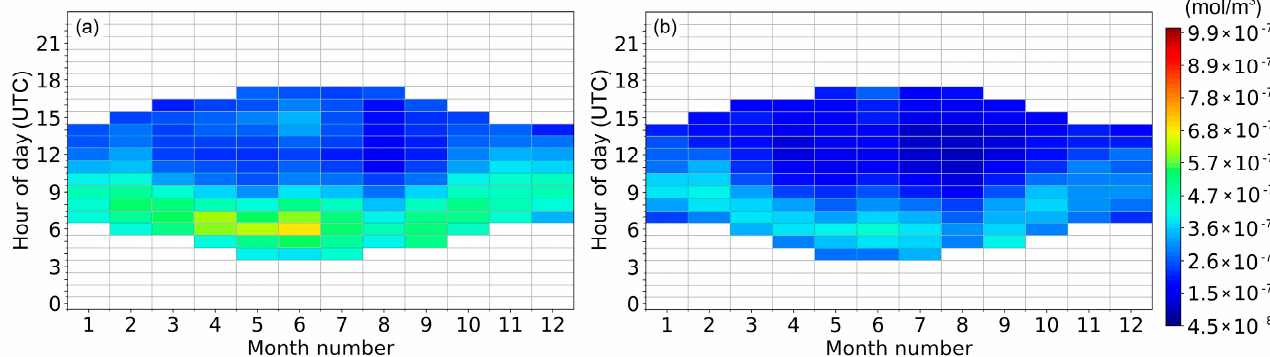
Figure 6. Hourly and monthly variation of SC-NO 2 for ( a ) weekdays and ( b ) weekends over the period 2017–2022.